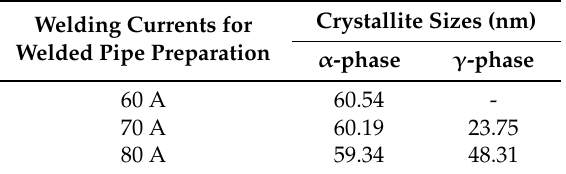
Figure 5. XRD patterns of the welded piping specimens obtained from welding currents of ( a ) 60, ( b ) 70, and ( c ) 80 A . Table 3. The crystallite sizes of metallurgical phase in welded pipes.